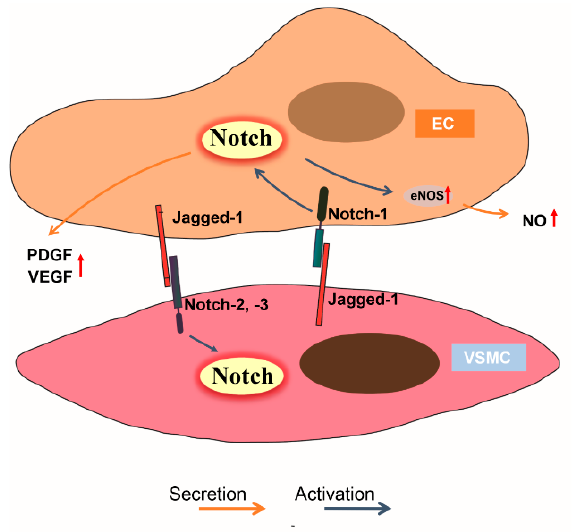
Figure 3. Notch signaling in cell-cell communication between endothelial cells (ECs) and vascular smooth muscle cells (VSMCs). In the process of direct cell-cell interaction between ECs and VSMCs, EC membrane ligand Jagged-1 is recognized by Notch-2, -3 in VSMCs; reciprocally, VSMCs Jagged-1 binds with EC Notch-1 receptor and activates the Notch downstream pathway in ECs (also see Table 1A). In addition, activation of Notch signaling induces nitric oxide (NO), platelet-derived growth factor (PDGF), vascular endothelial growth factor (VEGF) and other factors’ production from ECs via autocrine and paracrine process; these factors can regulate EC and VSMC proliferation, migration, differentiation and play different roles in neointimal hyperplasia (see Table 1B).